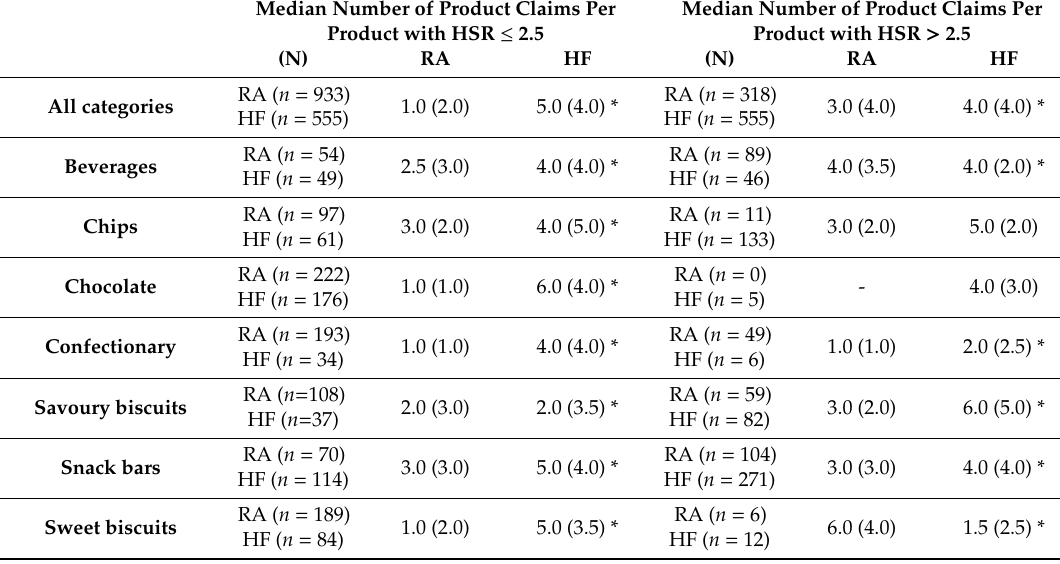
Table 2. Comparison of the median (IQR) product claims displayed on health food (HF) snack products sold in supermarkets and specialty HF stores to equivalent products sold in regular aisles (RA) of supermarkets, by product category for products with an HSR ≤ 2.5 and products with an HSR > 2.5. Di ff erences in median (IQR) claims displayed were assessed via Mann-Whitney U tests. Median Number of Product Claims Per Median Number of Product Claims Per Product with HSR ≤ 2.5 Product with HSR >